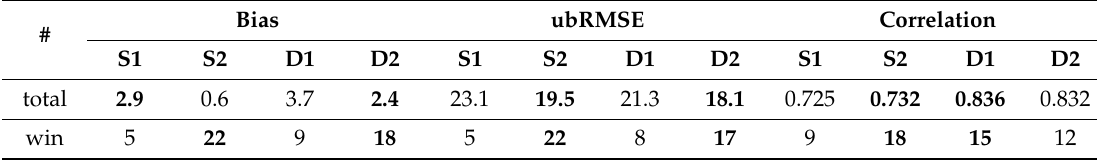
Table 4. Total validation score for USCRN cropland validation site.